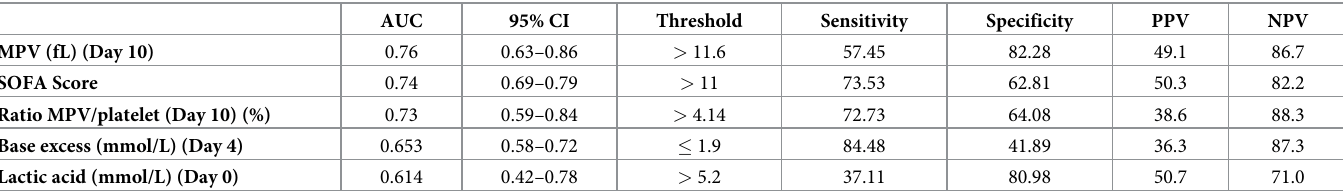
Table 2. Comparison of area under the curves of continuous clinical and biological variates discriminating survivors and nonsurvivors.